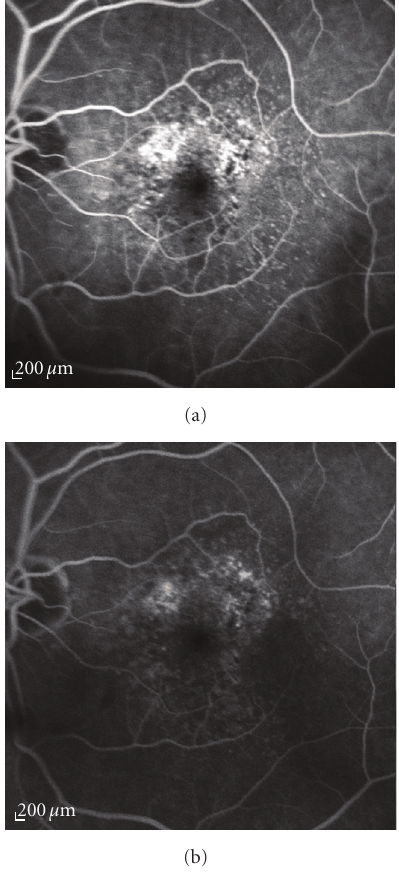
Figure 4: Fluorescein angiography of an occult choroidal neovas- cularization. (a) Early and (b) late angiograms: the lesion appears within 1-2 minutes from the start of the exams and persists during the late phase; it is characterized by areas of irregular elevation of the retinal pigment epithelium that present stippled